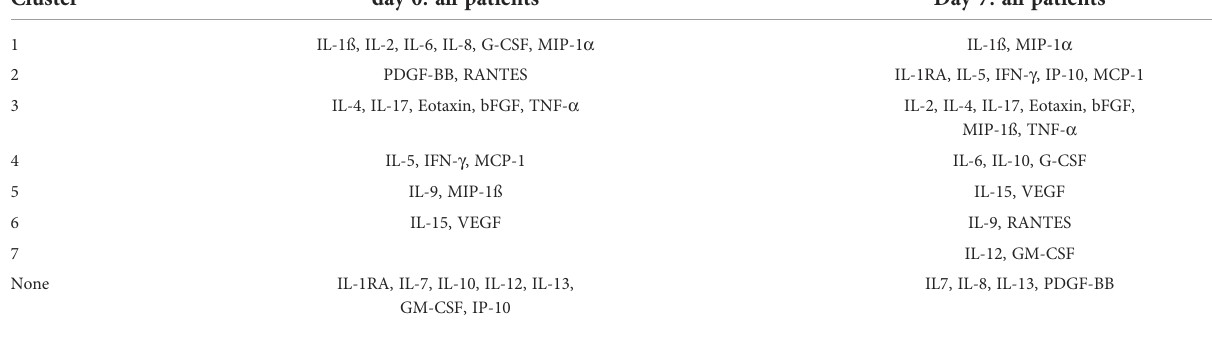
TABLE 2A Cluster report for the absolute values of the correlation matrix of all patients on day 0 and day 7. Cluster*